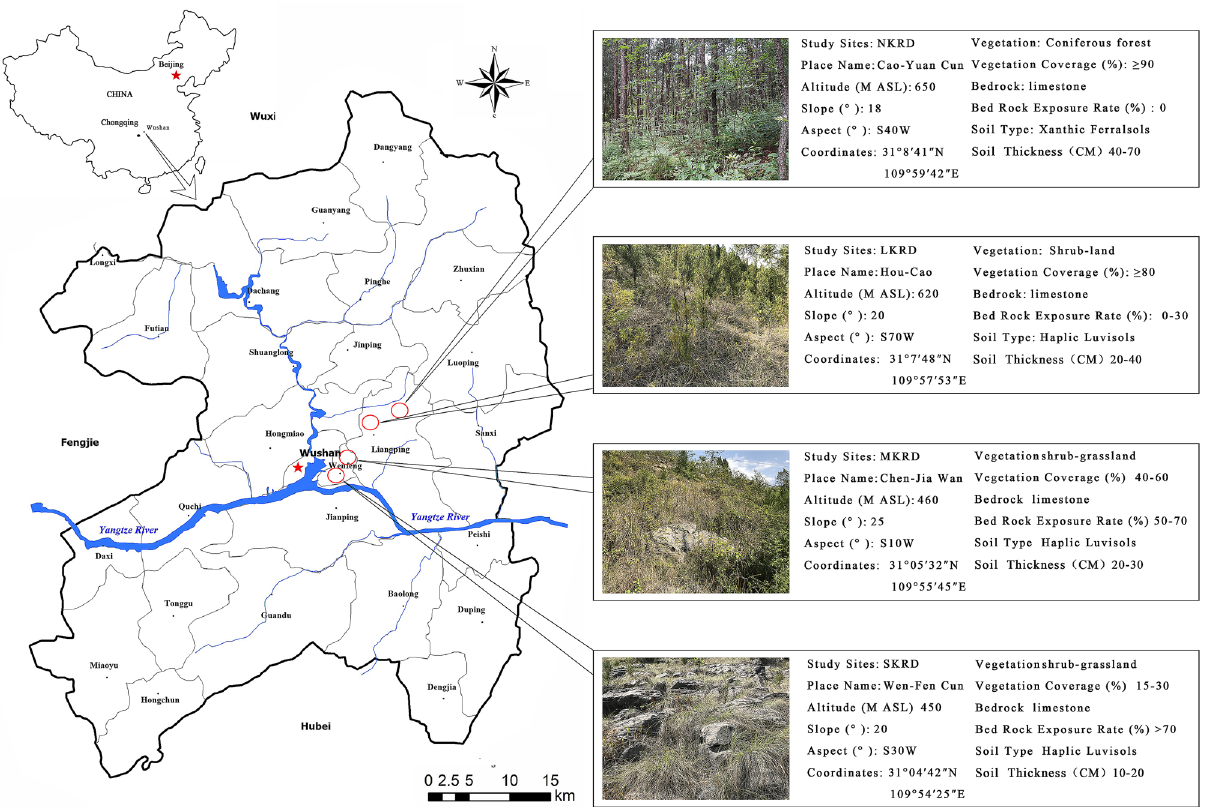
Figure 5. Study sites overview. Geographic features, soil type, bedrock exposure rate, and vegetation coverage are summarized in the figure. Classification of KRD is based on vegetation coverage, soil depth, and bedrock exposure rates. No KRD (NKRD), latent KRD (LKRD), moderate KRD (MKRD), and severe KRD (SKRD). Figure 1 was generated by the authors using mapinfo (v. 12.0.2) and Adobe Photoshop